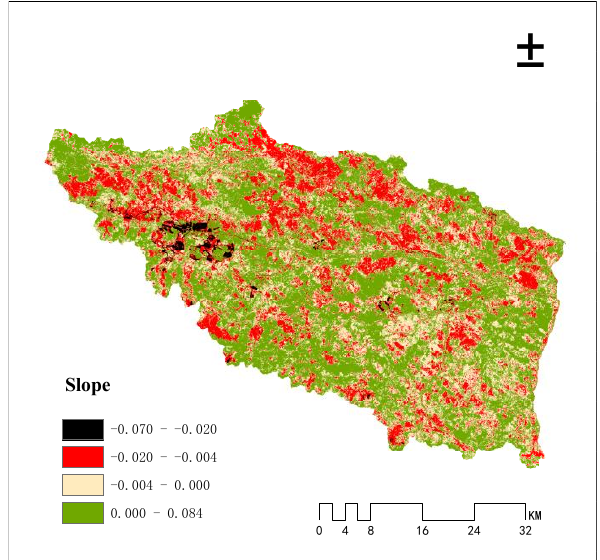
Figure 3. Slope of FVC in the Muli region from 2000 – 2021.